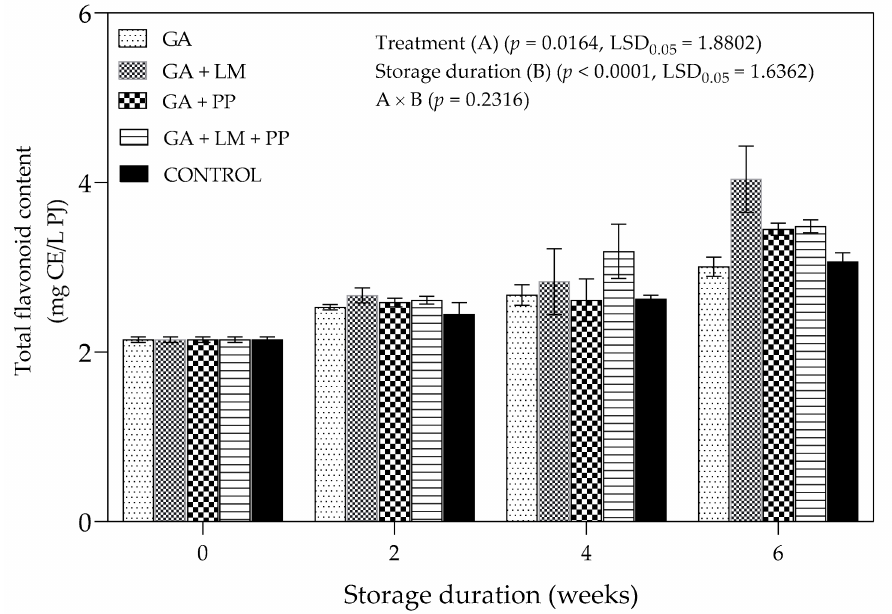
Figure 12. Total flavonoid content (mg CE/L PJ) of ‘Wonderful’ pomegranate whole fruit coated with gum arabic (GA) coatings enriched with lemongrass oil (LM) (0.1% v/v ) and/pomegranate peel extract (PP) (1% w/v ) and stored at 5 ± 1 ◦ C (95 ± 2% RH) for 6 weeks followed by 5 d at shelf-life conditions (20 ± 1 ◦ C and 60% RH). Vertical bars represent the standard error (SE) of mean values calculated from three measurements (Aril juice extracted from 10 fruit = 1 replicate = 1 measurement). LSD 0.05 represent least significant difference ( p <